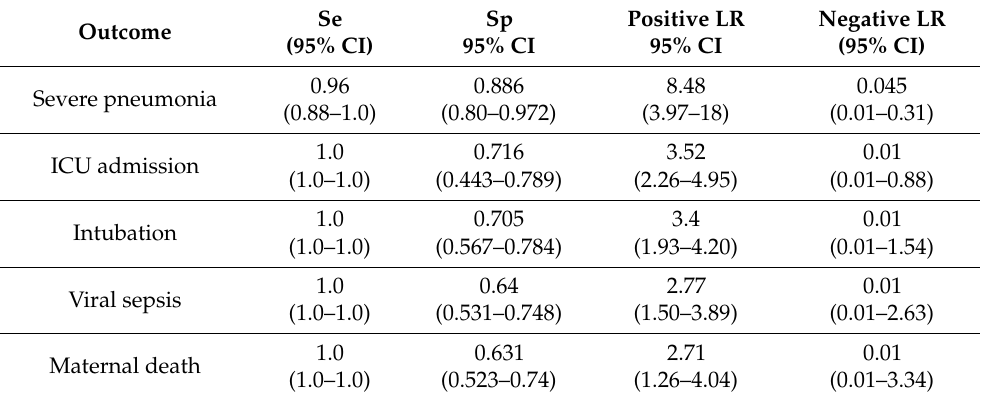
Figure 2. Area under the receiver-operating-curve (ROC) of sFlt1-1/ANG-II ratio for the prediction of severe pneumonia by COVID-19. ROC 0.9608. The detection rate (true-positive rate [TPR]) for severe pneumonia, at (A) 5% and (B) 10% false-positive rate (FPR) were 52% and 88%, respectively. Table 4. Performance of sFlt-1/ANG-II ratio ≥ 3.06 for the prediction of adverse maternal